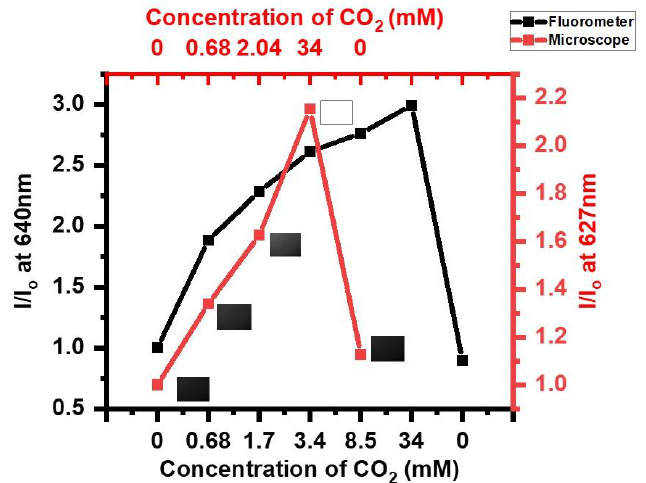
Figure 7. Changes in emission intensity (I/I o ) for NR solution with respect to different CO 2 levels as measured by the spectrofluorometer and epifluorescent microscope. The inset pictures show the relative emission brightness of the sample at different CO 2 concentrations. The inset images are the final, saturated fluorescent images of samples at different gas concentrations monitored on the epifluorescent microscope. Before saturation, images are taken at 10 min intervals during CO 2 exposure and at 20 min intervals during N 2 reversibility. Table 2. Carbon dioxide sensitivity numbers reported from absorbance/UV-Vis data, fluorescence data acquired using the spectrofluorometer, and epifluorescence using the Zeiss epifluorescence microscope. The concentrations of gases for epifluorescence studies were selected based on the technical limitation of the microscope gas chamber.